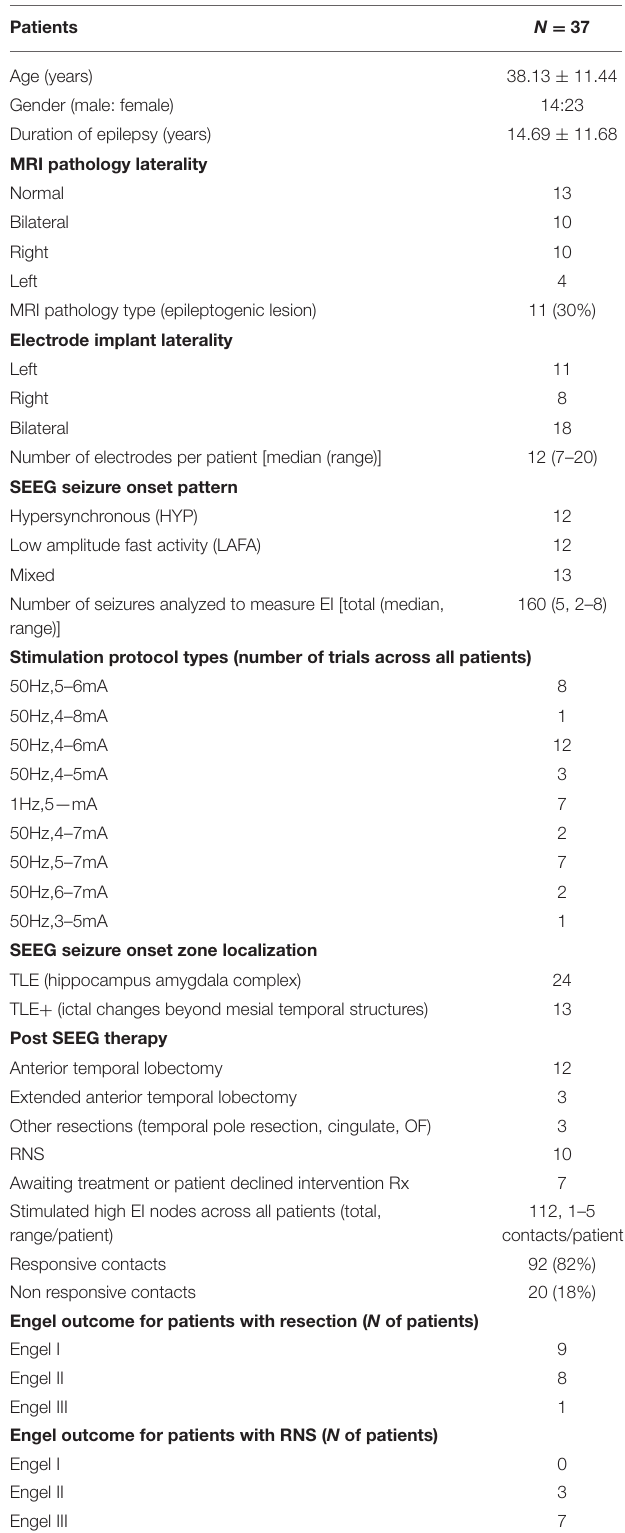
TABLE 1 | Clinico-demographic characteristics of the